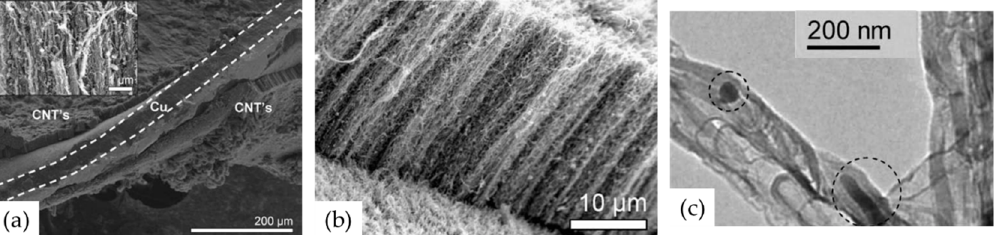
Figure 8. SEM micrographs of VACNT decorated on 20nm TiN DBL on Cu: ( a ) low with zoom insert and ( b ) high magnification of VACNT zone; ( c ) TEM images of recovered CNT samples with highlighted zones of Fe catalyst within the CNT inner core. Reprinted with permission from Garcia-Céspedes, Carbon; Ref. [83] copyright 2008, Elsevier.